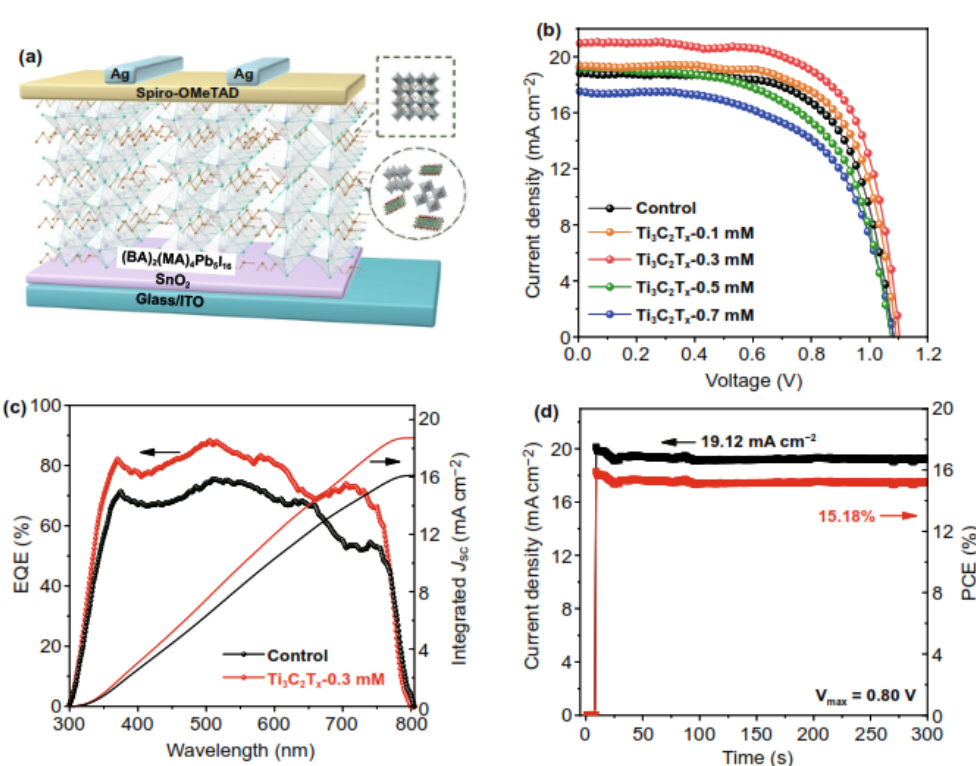
Figure 5. ( a ) Schematic representation of devices with the structure glass/ITO/SnO 2 /2D perovskite/SpiroOMeTAD/Ag. ( b ) JV curves from devices with different amounts of Ti3C2Tx doping. ( c ) EQE spectra and integrated Jsc of the control and optimised Ti 3 C 2 T x doping devices. ( d ) Stabilised power output and current density at a constant bias 0.80 V for the Ti 3 C 2 T x dopant devices. Reprinted with permission from ref. [99]. Copyright 2021 Springer Nature Switzerland AG. Part of Springer Nature.